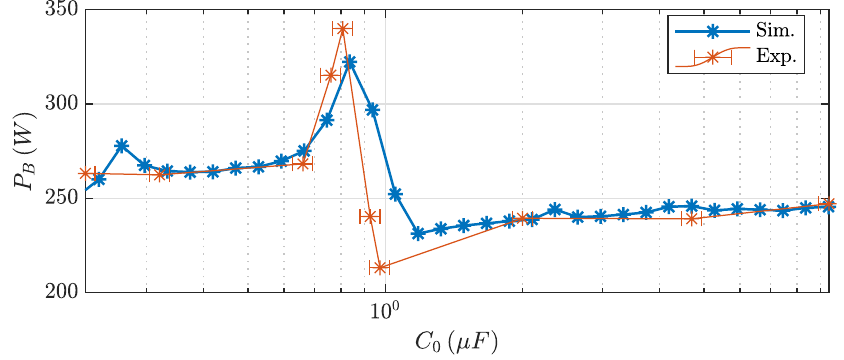
Figure 8. Total power transferred to the battery as a function of the filtering